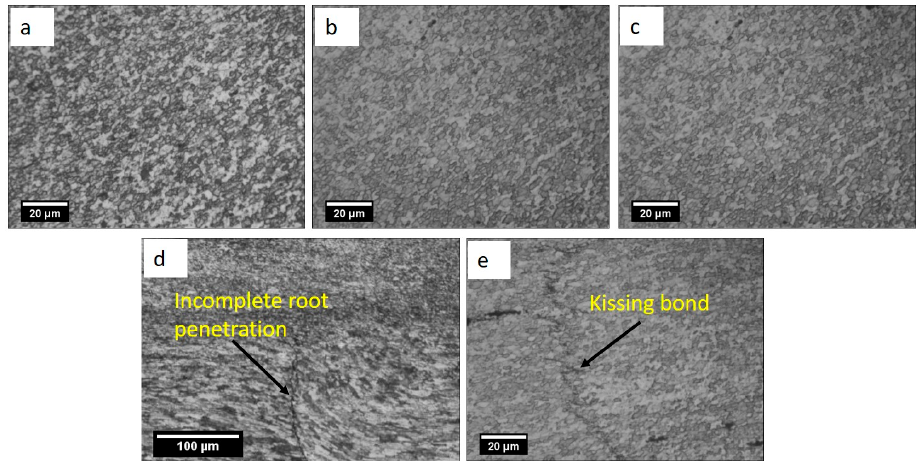
Figure 9. Scarf joint micrographs obtained for specimen produced by using tools of ( a ) cylindrical pin; ( b ) tapered cylindrical pin; ( c ) square pin; ( d ) hexagonal pin; ( e ) triangular pin.